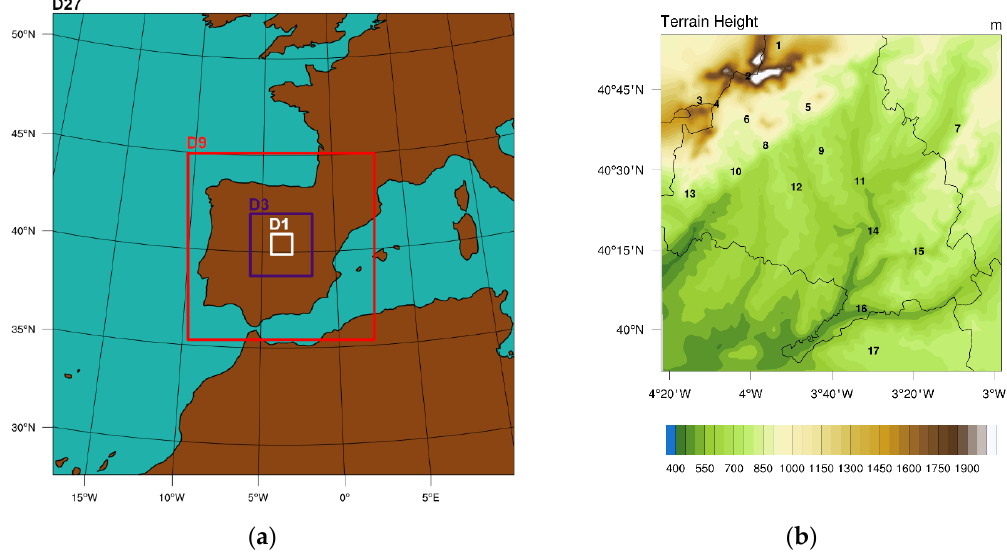
Figure 1. ( a ) Nested domains used in WRF simulations with 1° × 1° initial conditions’ grid resolution. Outer frame corresponds to domain D27. Only D9, D3, and D1 were used for simulations with 0.25° × 0.25° initial conditions’ grid resolution. ( b ) D1 with terrain elevation metres above sea level (m.a.s.l.), location, and assigned number of observation data stations. Station #11 corresponds to the Adolfo Suárez Madrid-Barajas International Airport (LEMD).